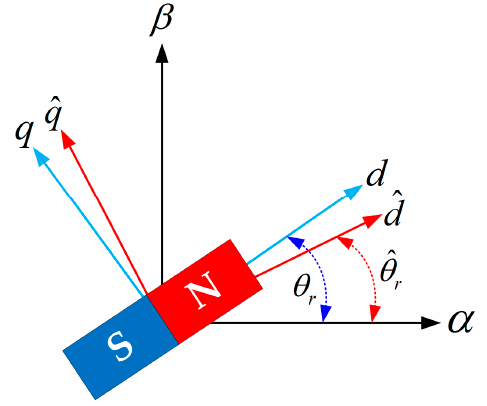
Figure 2. Space vector diagram of SPMSM.